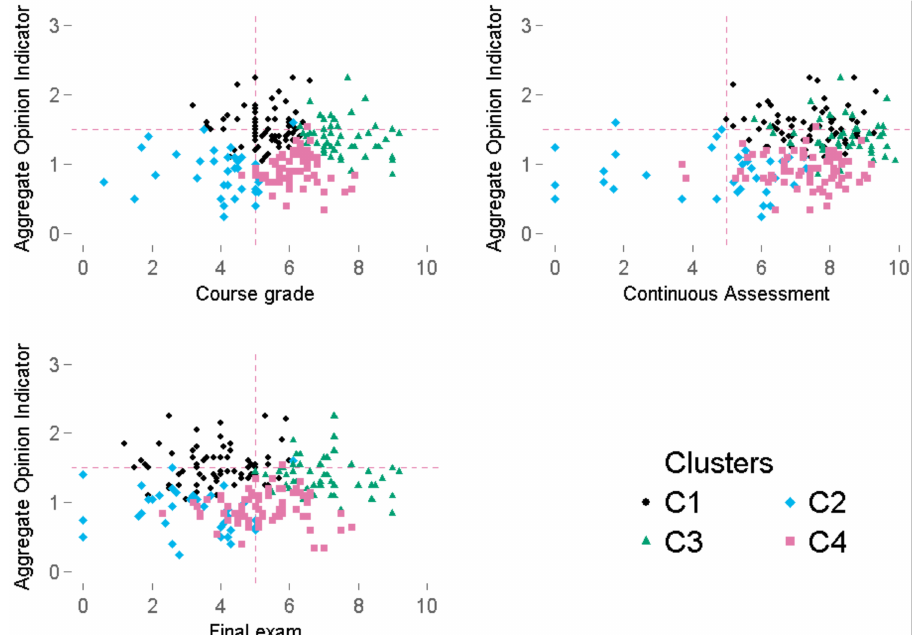
Figure 4. Distribution of student’s profile according to their opinion about ERT and academic performance.